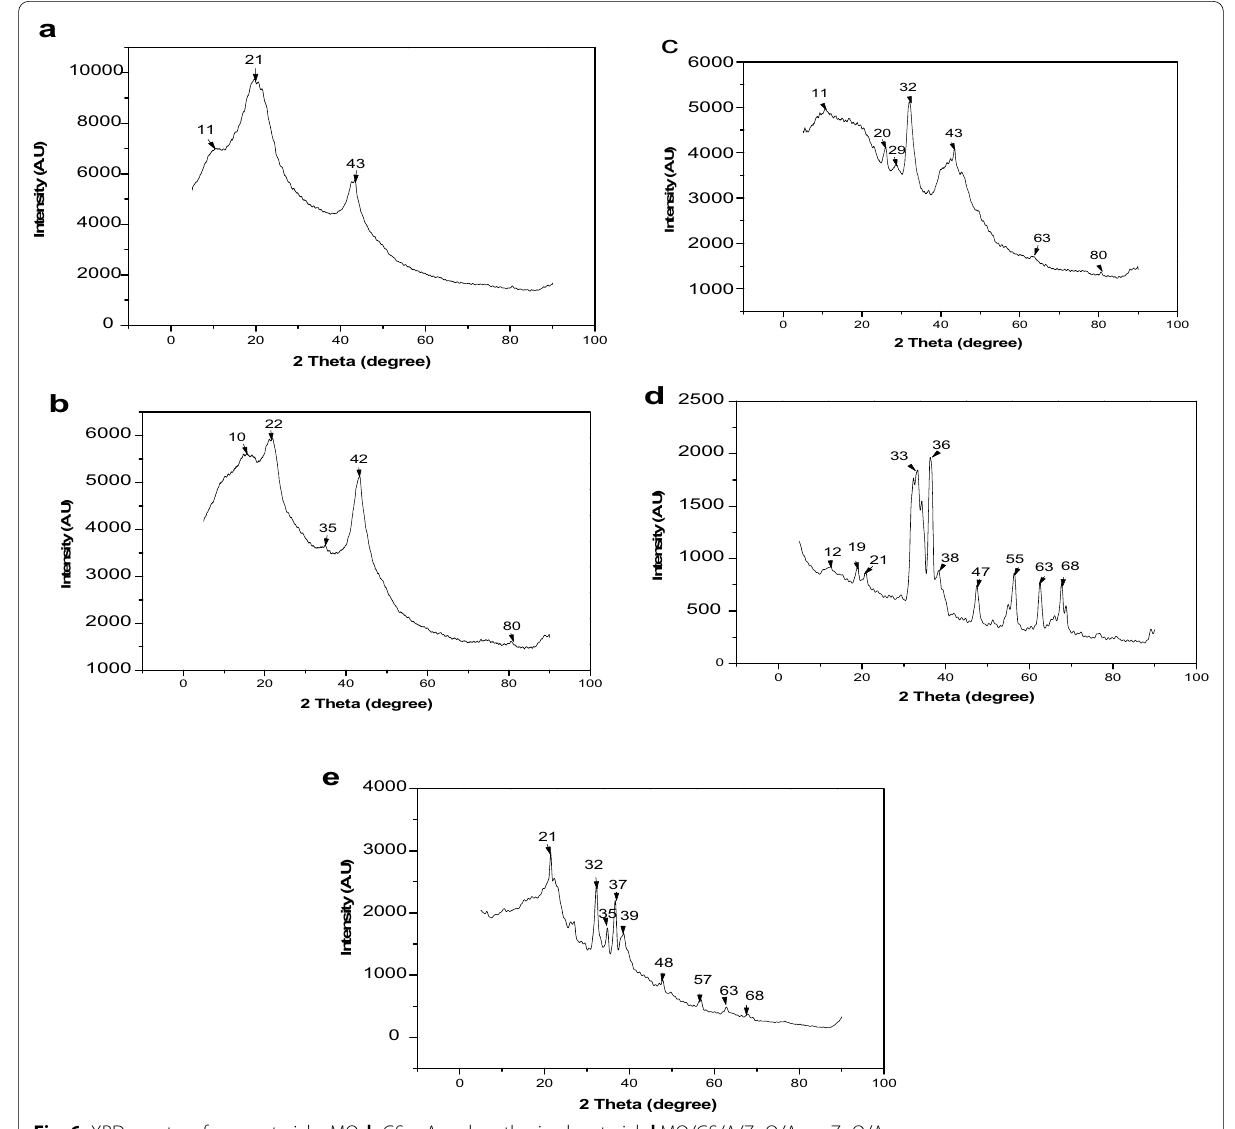
Fig. 6 XRD spectra of raw material a MO; b GS; c A and synthesized material d MO/GS/A/ZnO/Ag; e